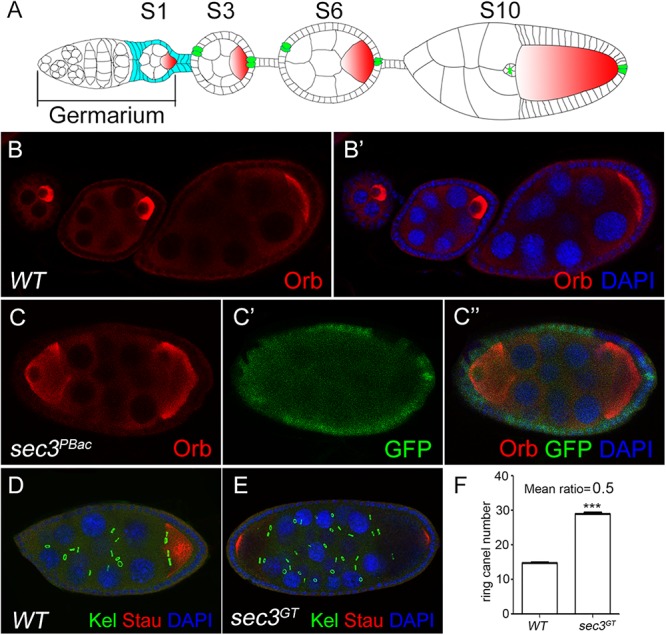
Loss of sec3 in follicle cells results in egg chamber fusion. (A) A model for Drosophila oogenesis showing egg chambers in different stages. Oocytes are in red and polar cells are in green from stage 3. Follicle cells cover all the germline cysts at the early stages and mainly cover the oocyte by stage 10. (B–B’) A wild type ovariole with three egg chambers, each of which has an oocyte. (C–C”) A compound egg chamber with sec3PBacclones showing two oocytes. (D) A wild type egg chamber showing 15 ring canals. (E) A compound egg chamber with two oocytes showing 30 ring canals. (F) Quantification of ring canal numbers in compound egg chambers and control egg chambers (29.5 ± 0.2 vs. 14.8 ± 0.1, n = 12, p < 0.0001). Images for Kel staining are overlays of the Z-section, as ring canals cannot be shown in a plane. In all the images in this report, the sec3 mutant clones are marked by an absence of GFP, and nuclei are stained by DAPI.